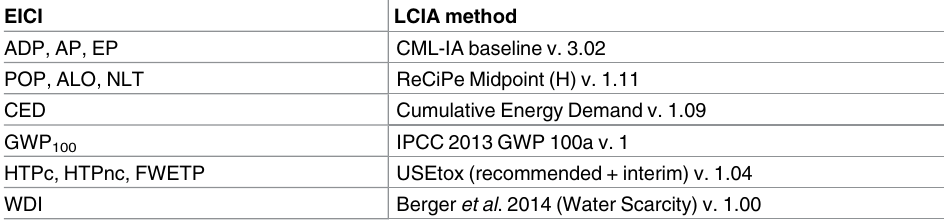
Table 4. Life cycle impact assessment (LCIA) methods for the evaluation of the environmental impact category indicators (EICI) in this study.